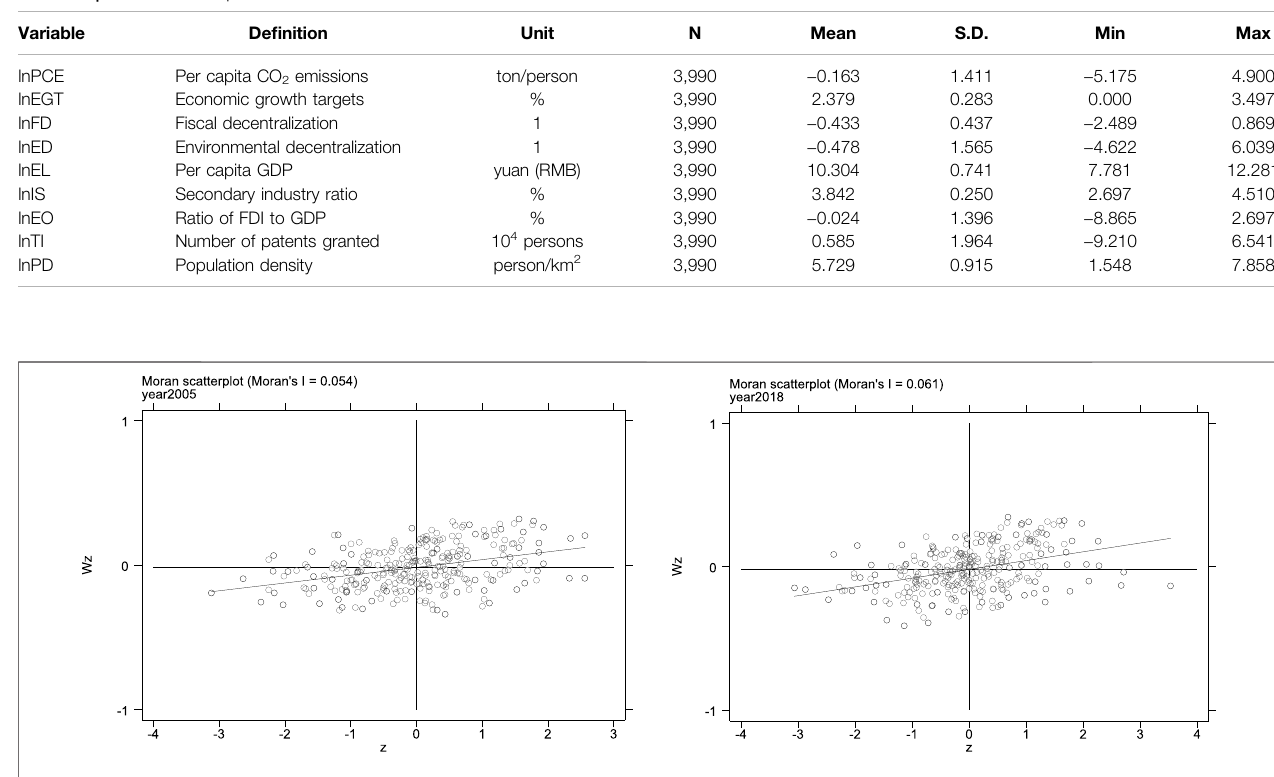
FIGURE 1 | Scatter plots of the local Moran ’ s I index for lnPCE in 2005 and 2018.